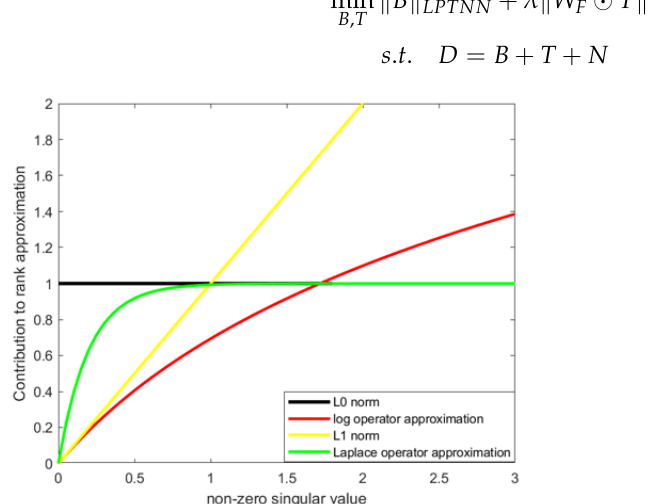
Figure 7. Comparison of contributions of singular values to rank approximation measured by different